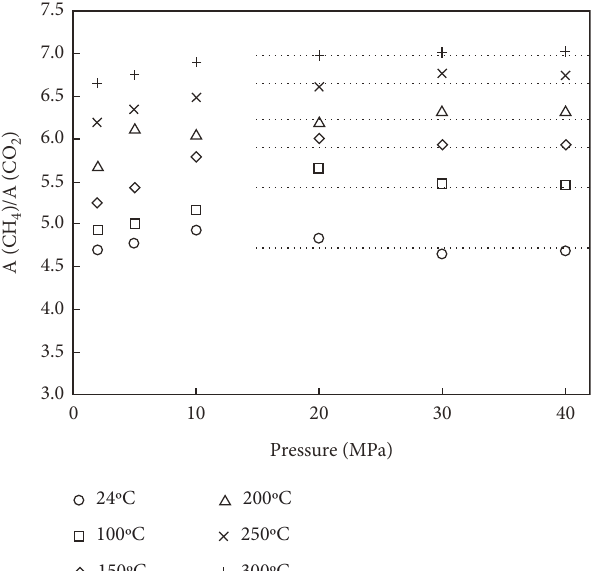
Figure 11: Relationship between the CH 4 to CO 2 peak area ratio and pressure at 50mol% CH 4 -50 mol% CO 2 mixture and temperatures ranging from 24 ° C to 300 °